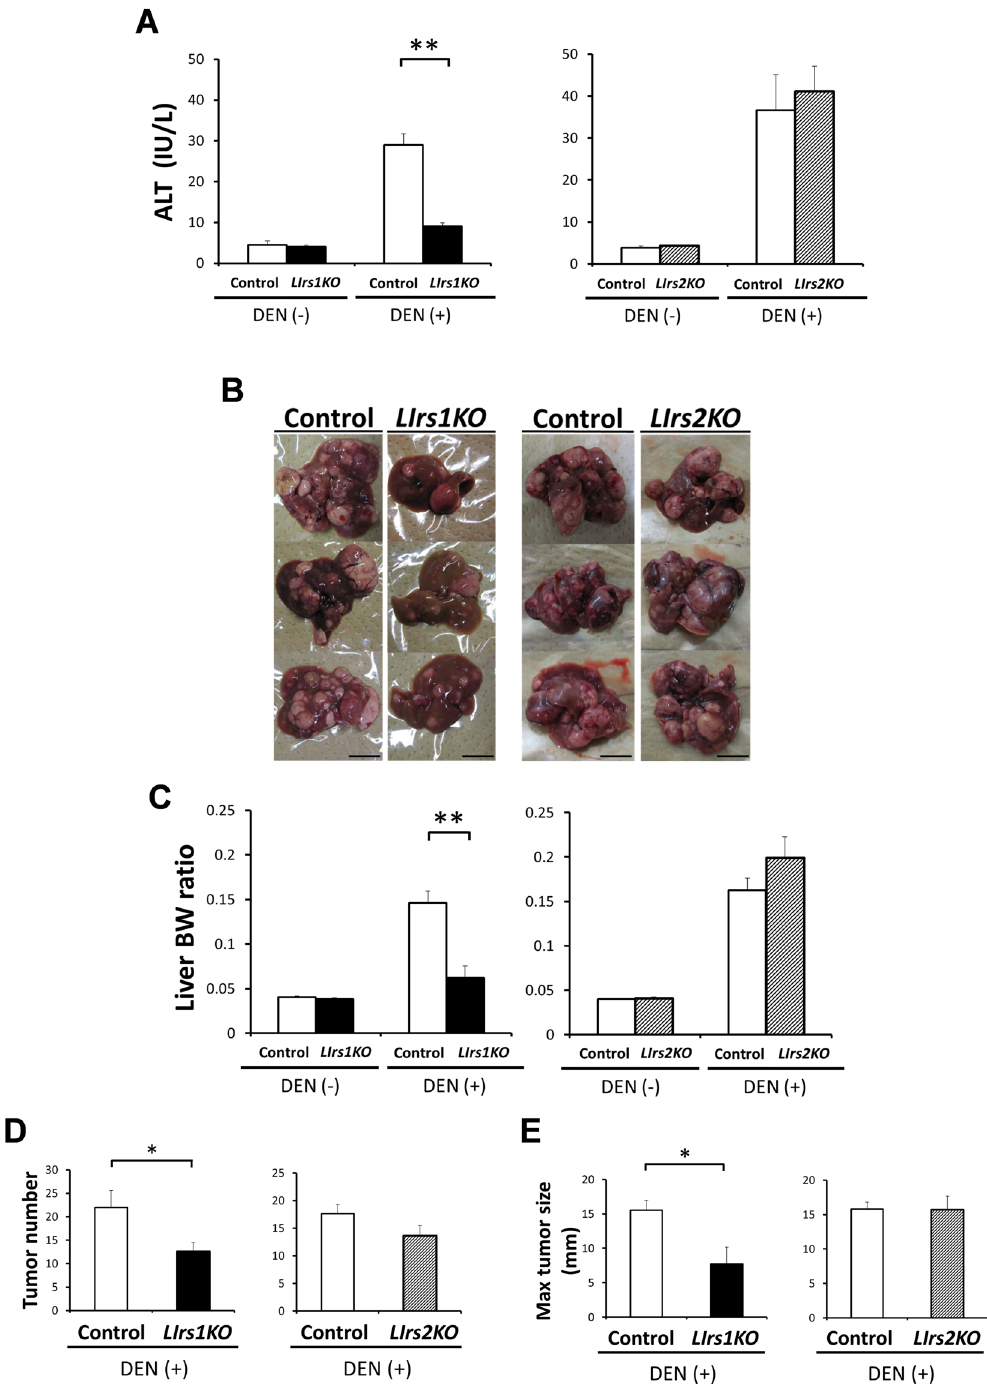
Figure 2. Loss of Irs1 in the hepatocytes suppressed DEN-induced hepatocarcinogenesis. Ten months after DEN administration, LIrs1KO and LIrs2KO mice were compared with respective control ( Irs1 lox/lox and Irs2 lox/ lox ) wild-type mice. ( A ) Serum levels of ALT. The mice in each group treated with not DEN but normal saline were used as negative controls. ( B ) Gross appearances of representative livers with tumors in each DEN- treated mouse group. Scale bar, 10 mm. ( C ) The liver: body weight ratio, ( D ) liver tumor numbers ( > 1 mm) and ( E ) maximal tumor size (diameter in mm) on the surface were determined in each DEN-treated mouse group. Values are the means ± SEM of data obtained from each group. DEN( − ), n = 6–9; DEN( + ), n = 11–12. * P < 0.05. ** P <